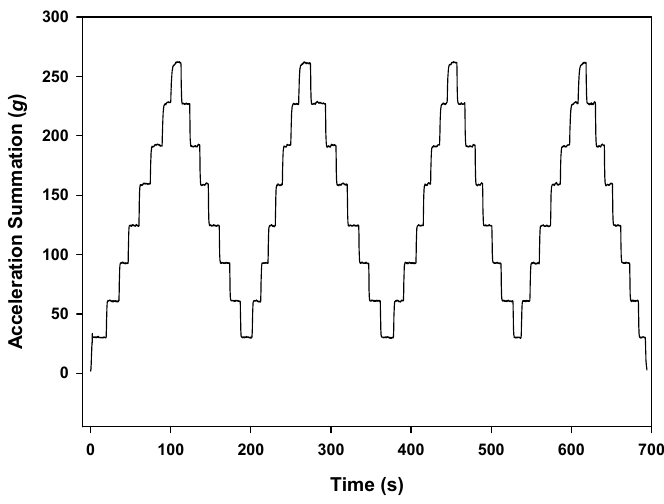
Figure 8. Raw acceleration recorded by BIRD II during calibration.